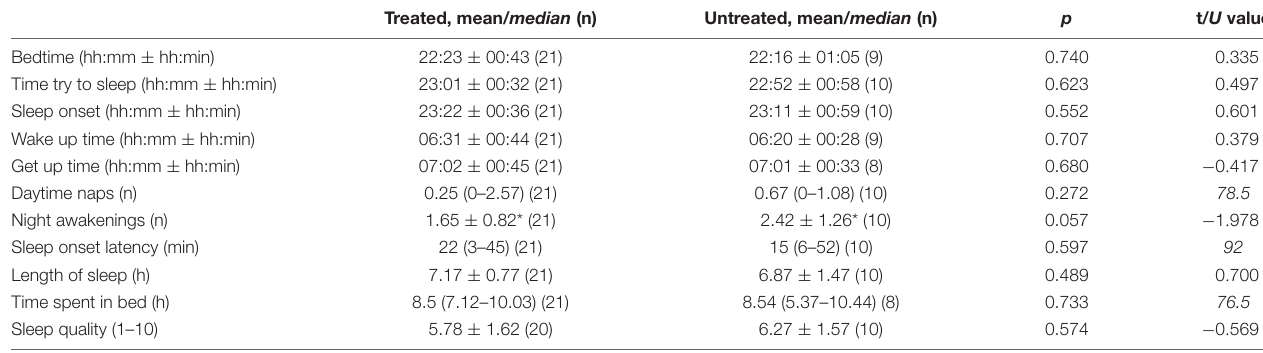
TABLE 2 | Sleep-wake timing based on daily diaries (entire hospitalization period). Treated, mean/ median (n) Untreated, mean/ median (n)